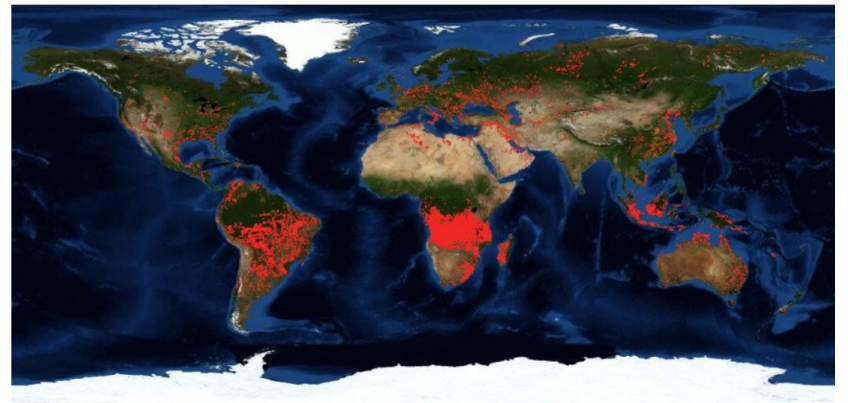
Figure 2. Fires on the planet Earth,